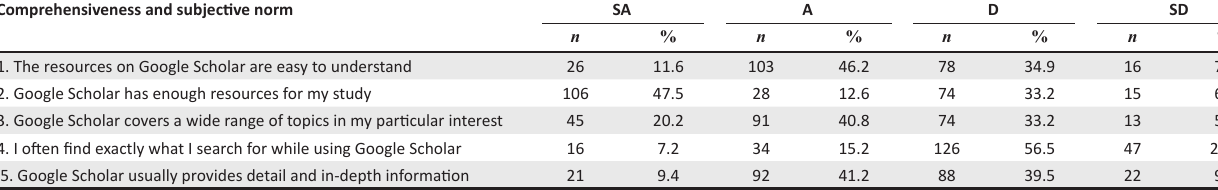
TABLE 5: Comprehensiveness and subjective norm.